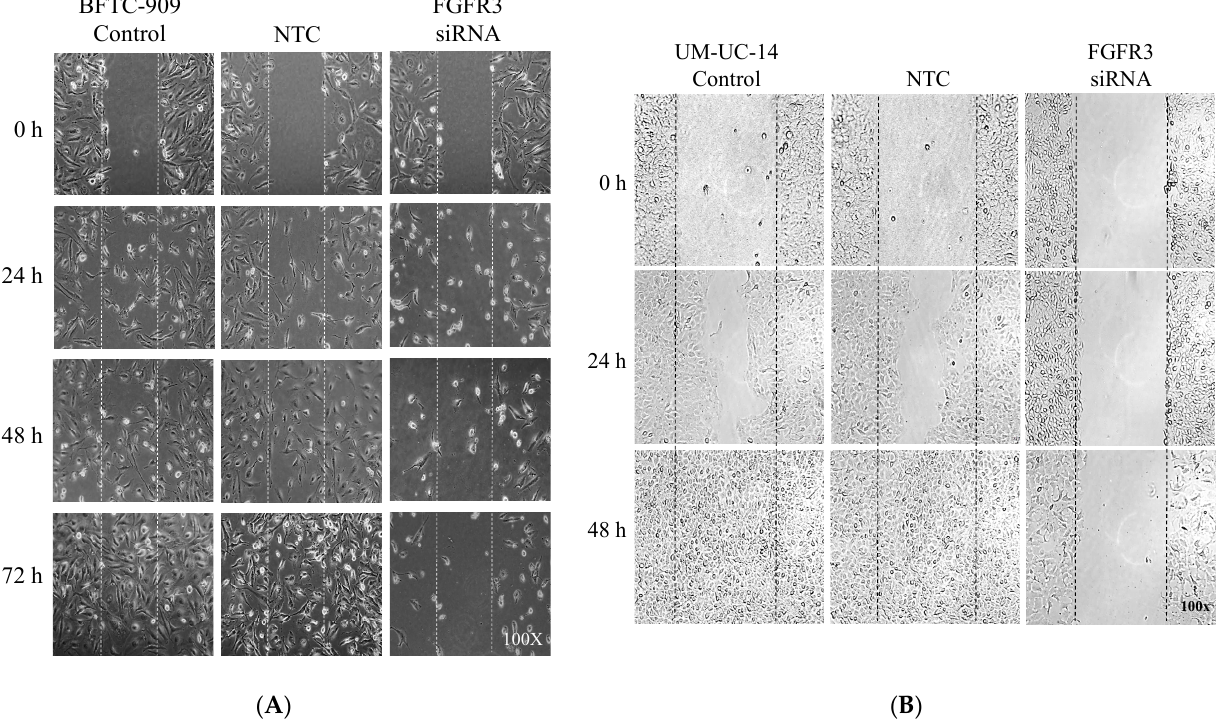
Figure 4. Suppressive effect of FGFR3 gene silencing on migration of cultured UTUC cells. Two UTUC cell lines, BFTC-909 ( A ) and UM-UC-14 ( B ), were treated with FGFR3-targeted siRNA or scramble non-target control (NTC), followed by consecutive microscopic documentation for the post-wounding closure at the indicated time points.